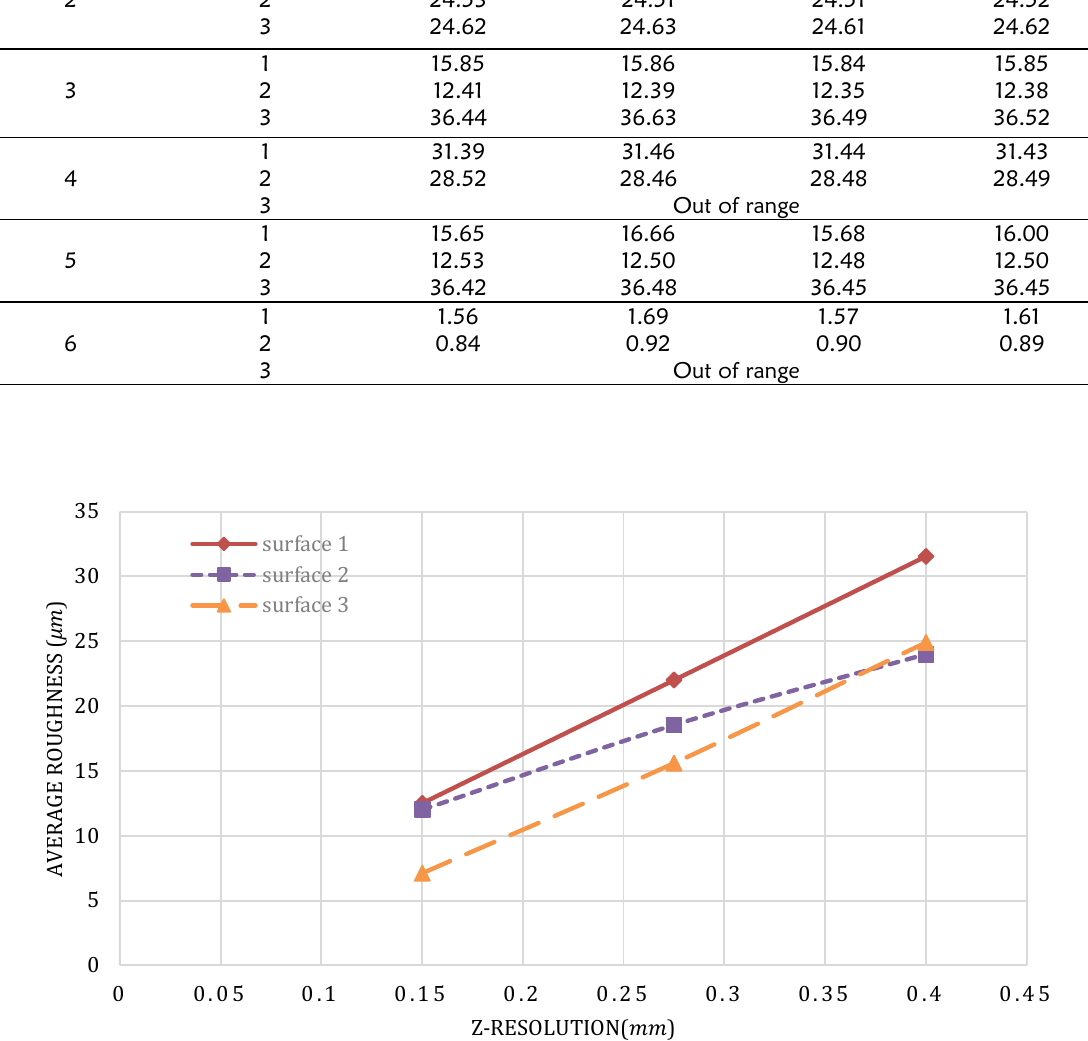
Average R a Value (µm)